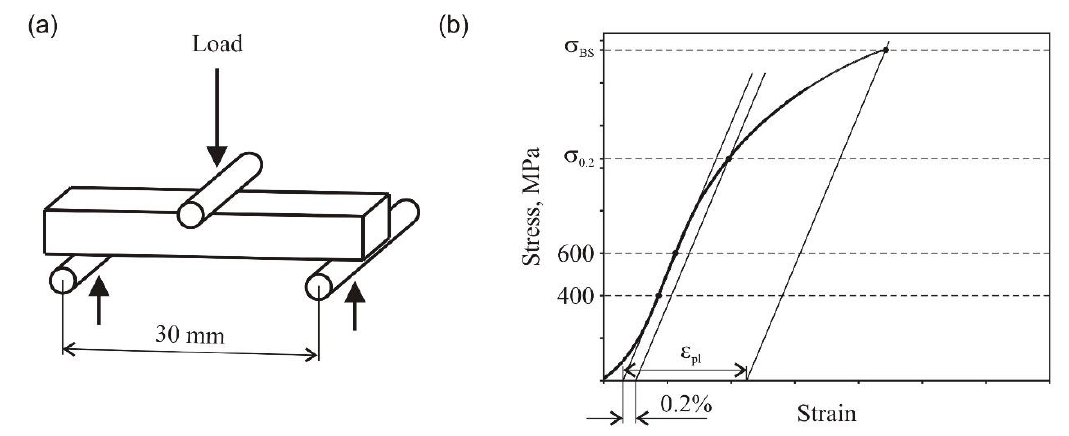
Figure 1. Three-point bend test fixture ( a ) and evaluation of bending strength ( σ BS ), offset yield strength ( σ 0.2 ), and plastic strain at failure ( ε pl ) from a bending curve ( b ) [27].